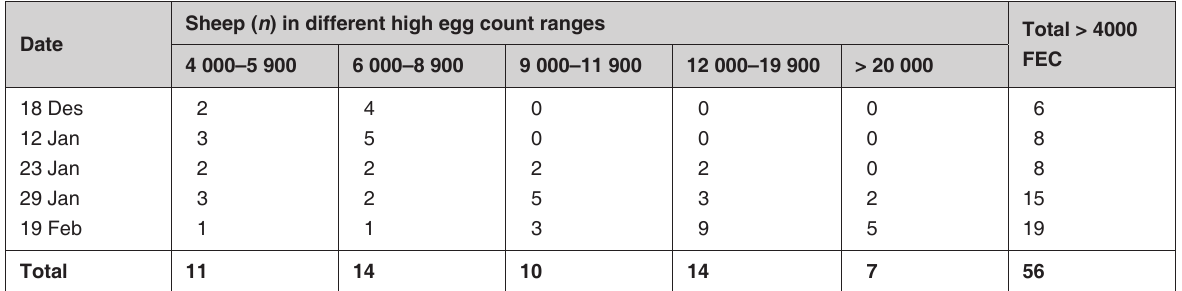
TABLE 3 Experiment 1 (Farm 1, wethers in replacement ram flock): Highest individual FECs of the TST-treated group of sheep Sheep ( n ) in different high egg count ranges